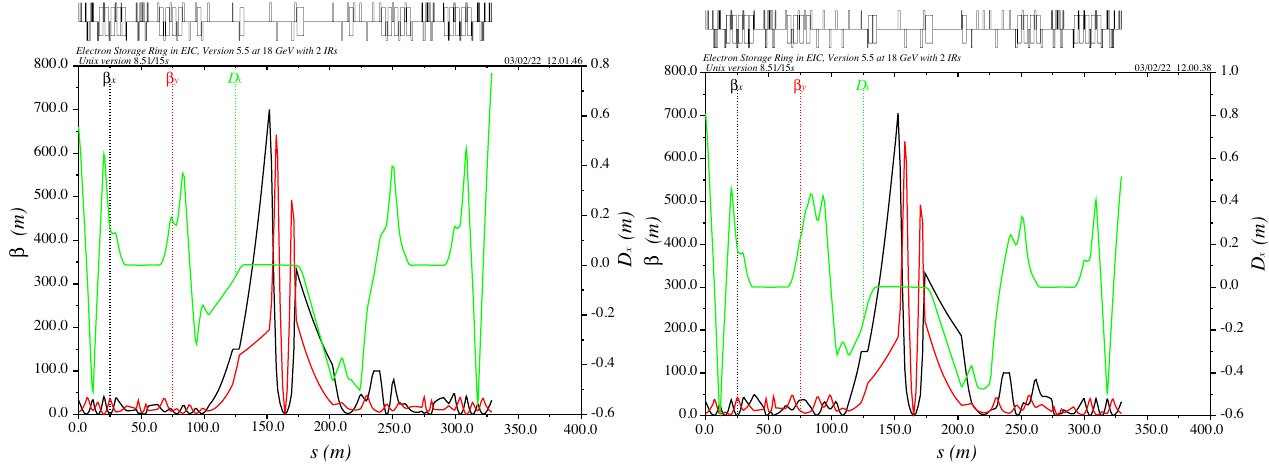
FIG. 2. Lattice functions in the interaction region 6 (left) and 8